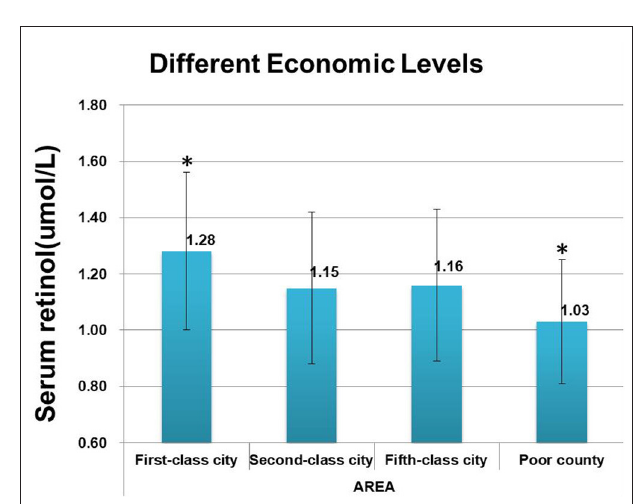
FIGURE 3 | Comparison of vitamin A levels in cities of different economic levels. *Significant difference from other groups ( p < 0.05).